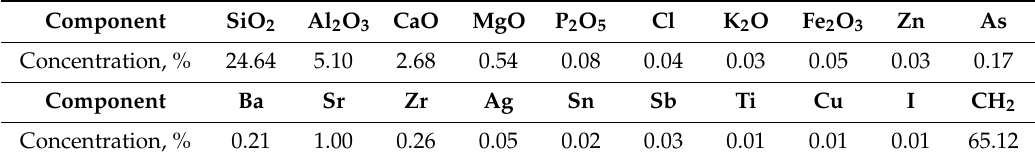
Table 7. Chemical composition (%) of an LCD panel.